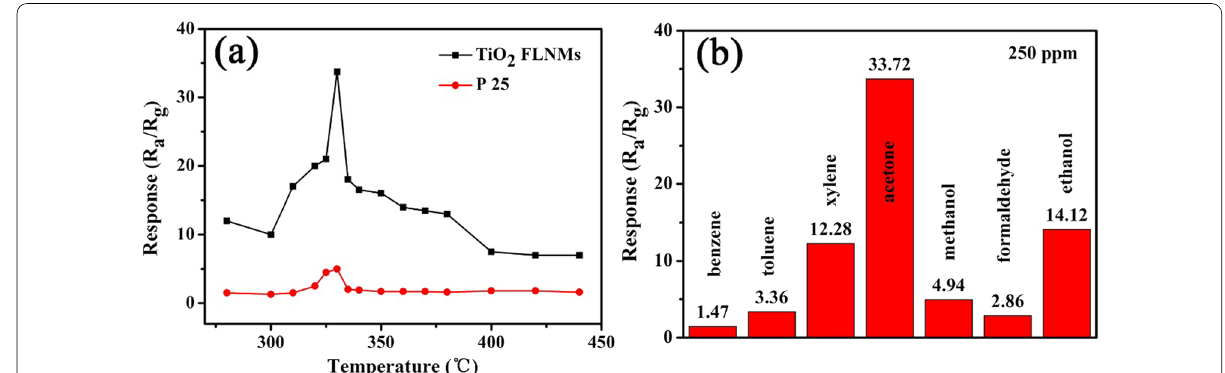
Fig. 6 a Response of TiO 2 FLNMs an Degussa P25 powder toward 250 ppm acetone at different operating temperature; b selectivity test of TiO 2 FLNMs gas sensor (250